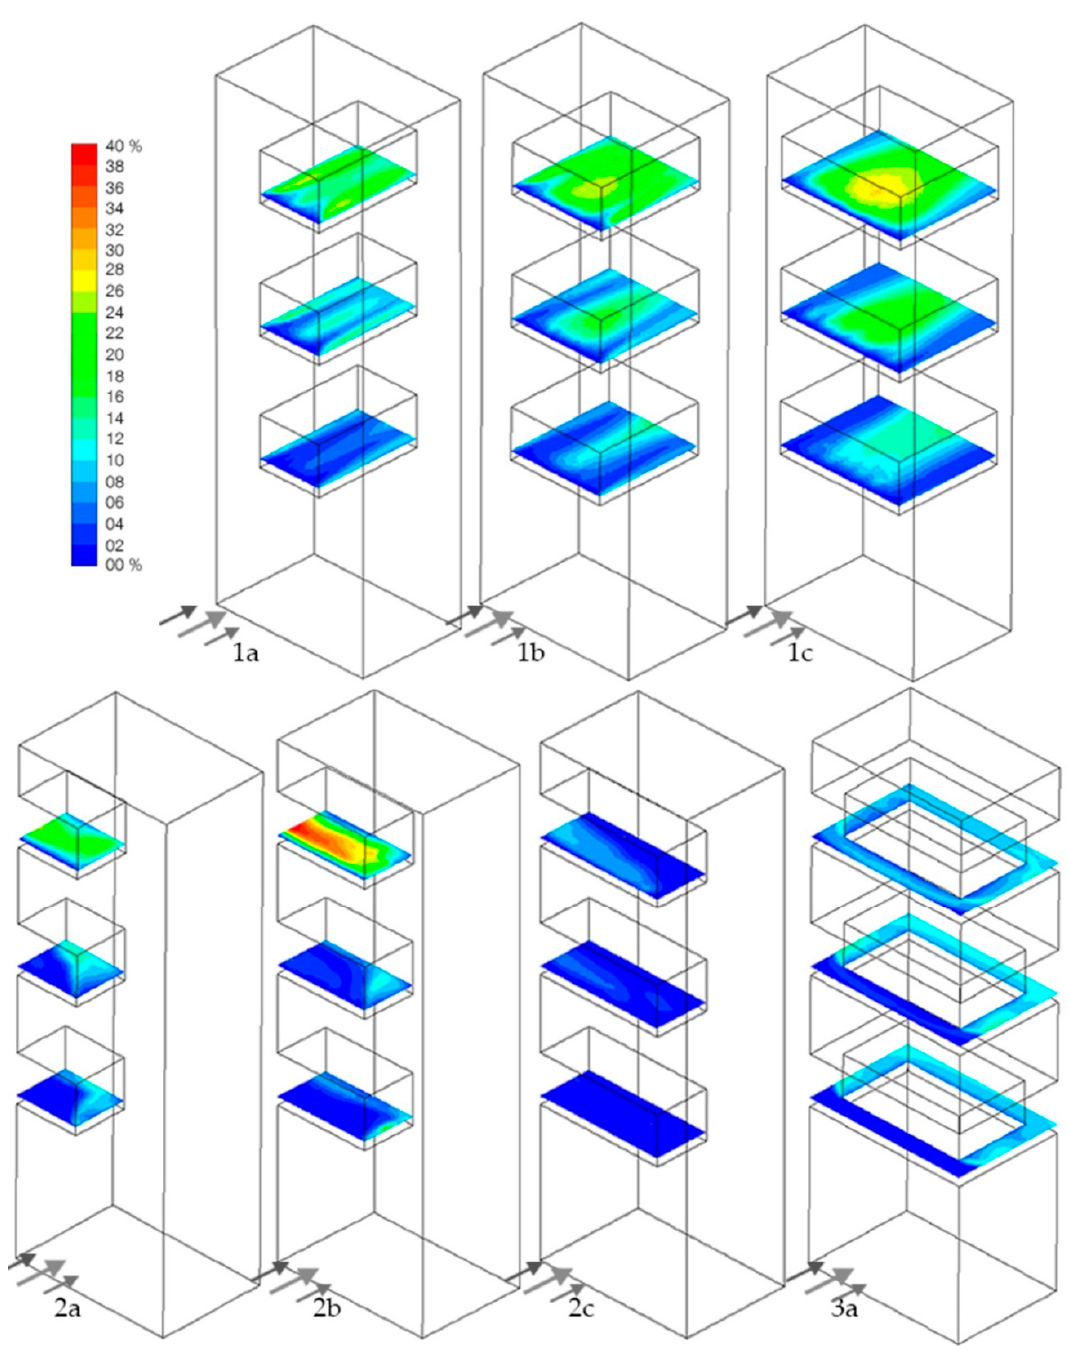
Figure 10. Turbulence intensity at different sky garden heights; (1a) Central sky garden b/B = 0.4, (1b) Central sky garden b/B = 0.6, (1c) Central sky garden b/B = 0.8, (2a) Corner sky garden b/B = 0.4, (2b) Corner sky garden b/B = 0.6, (2c) Corner sky garden b/B = 0.8, (3a) Periphery sky garden a/A = 0.5.